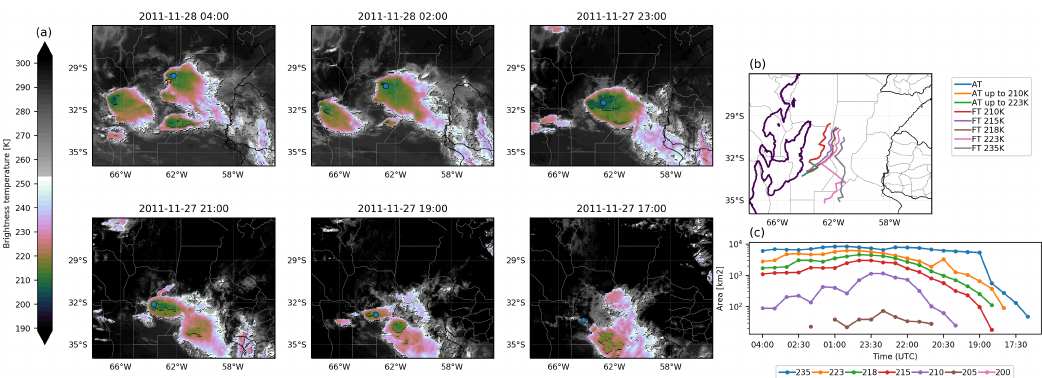
Figure 5. Same as Figure 4, but for 28 November 2011.